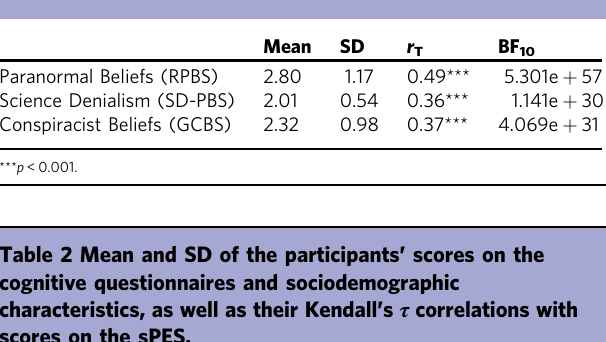
Table 1 Mean and SD of the participants ’ scores on the unwarranted beliefs questionnaires and their correlations with the scores on the sPES.